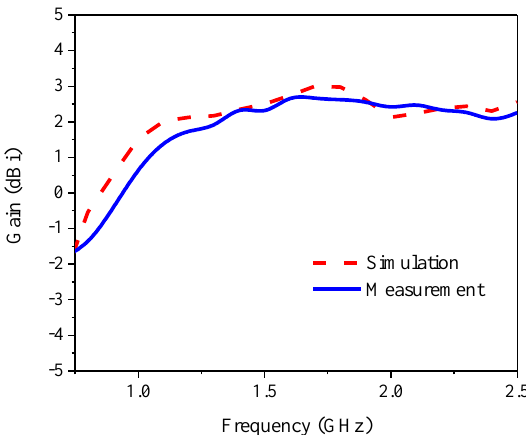
Figure 20. The simulated and measured gain of the proposed antenna.